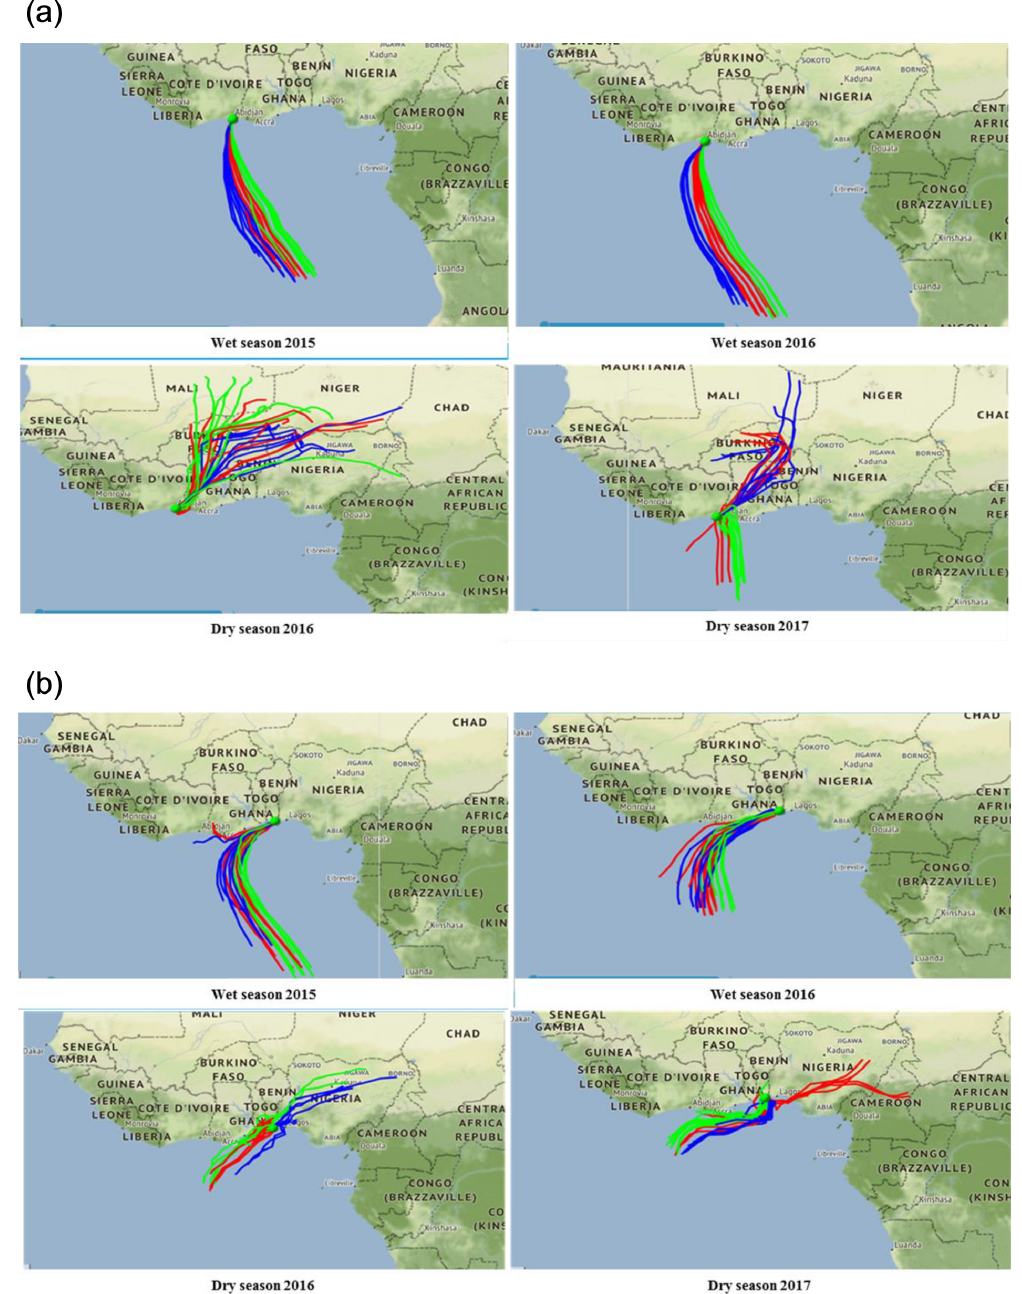
Figure 5. Back trajectories arriving at Abidjan (a) and Cotonou (b) for each season (WS2015, WS2016, DS2016, and DS2017).